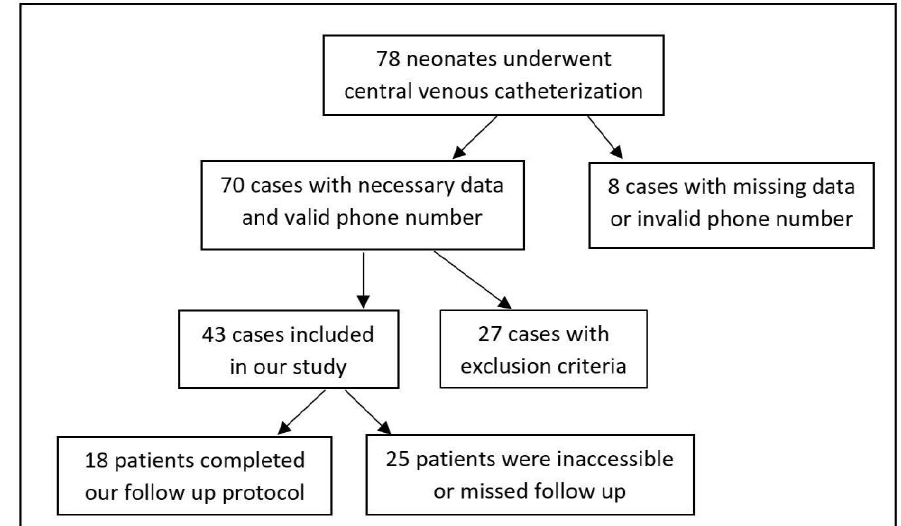
Figure 1. Study data mining and methodologic case selection